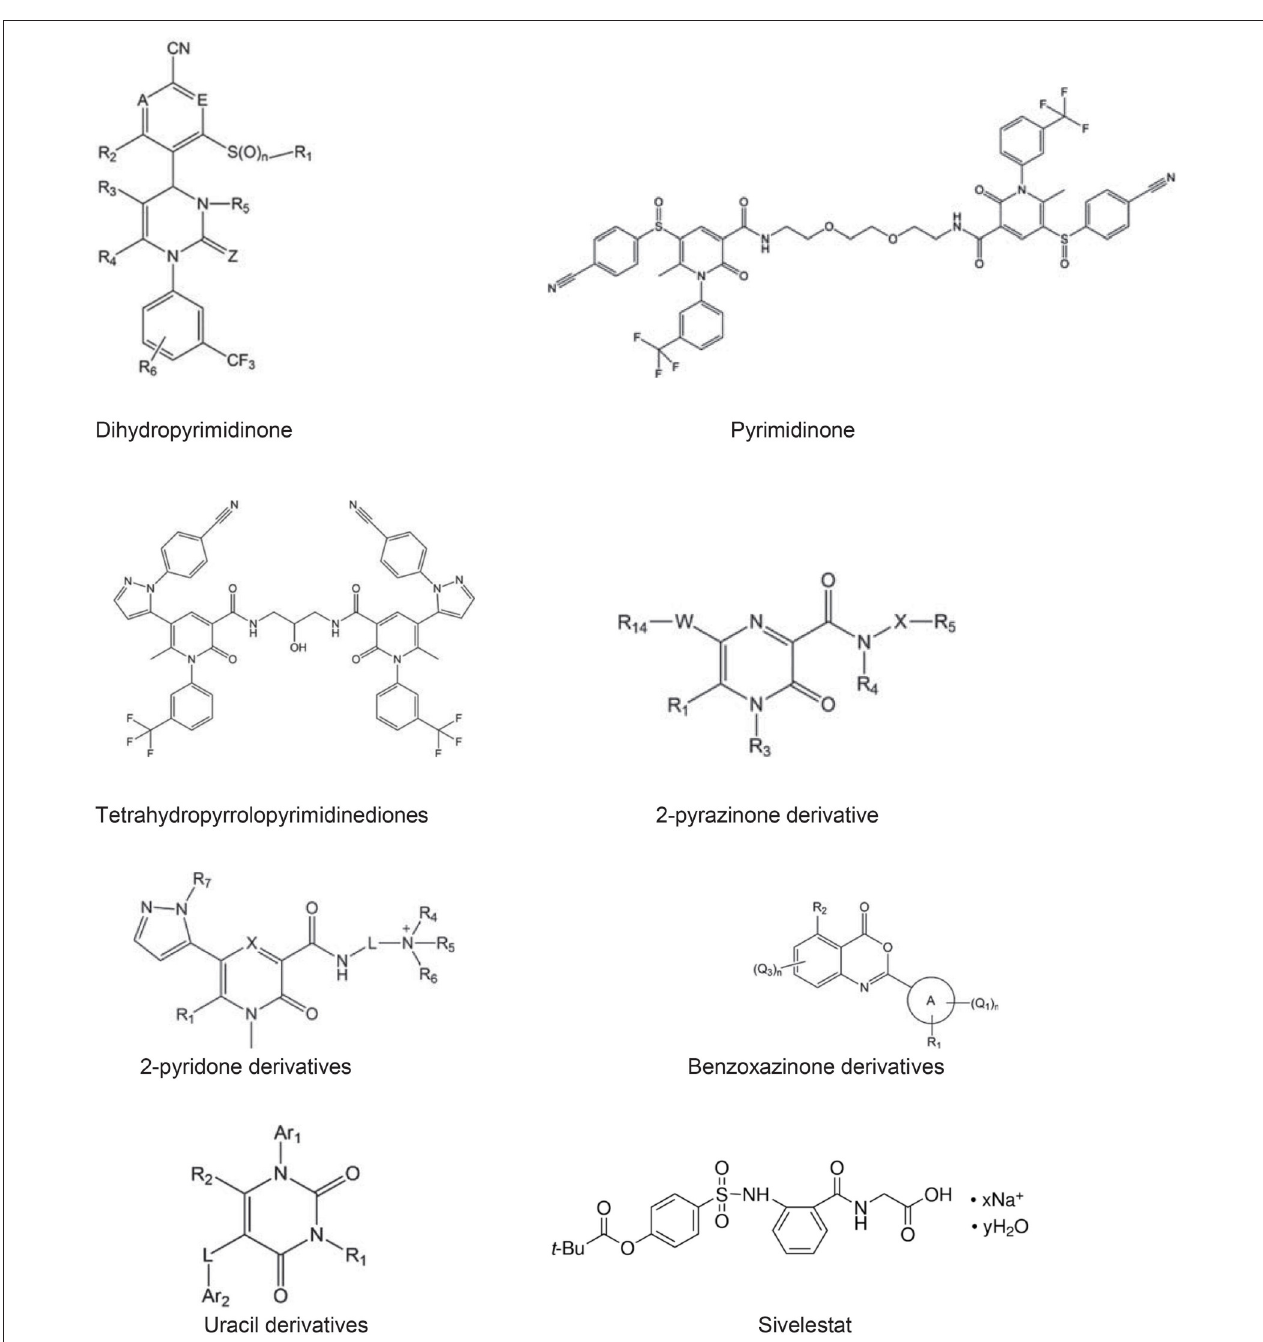
FIGURE 4 | Neutrophil elastase based inhibitors ; Pyrimidinone, Pyrimidinedione, and Pyrimidine derivative s are act as NE inhibitors . The IC 50 values of dihydropyrimidinone (0.3nM), pyrimidinone (0.61nM), tetra hydro pyrrolo pyrimidinediones (0.20nM), 2-pyrazinone derivative (0.33nM), 2-pyridone derivatives (3.5 nM), benzoxazinone derivatives (15nM), uracil derivatives (3.5nM) (Gadek and Pacht, 1990; Vandivier et al., 2002; Iba et al., 2006), sivelestat (46nM), indicate that above derivatives are potential inhibitors (Ainge et al., 2010; Hsieh et al., 2010; Ray et al., 2010; Bergstrom et al., 2011; Von Nussbaum et al., 2012).